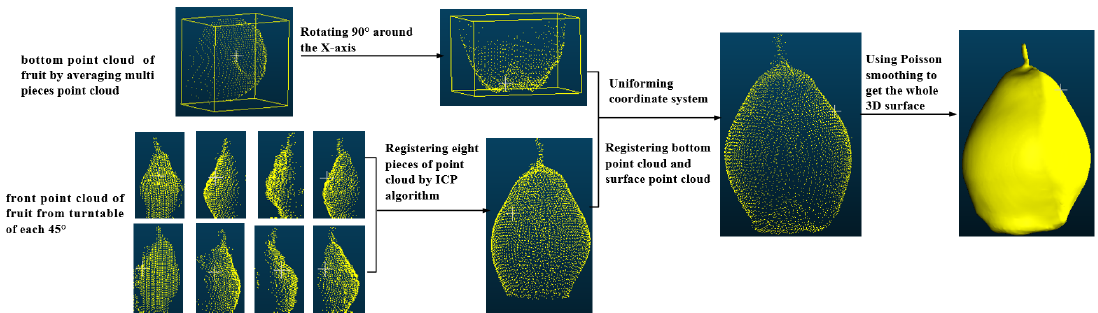
Figure 2. Registering the whole model of fruit using point cloud from different coordinate systems.